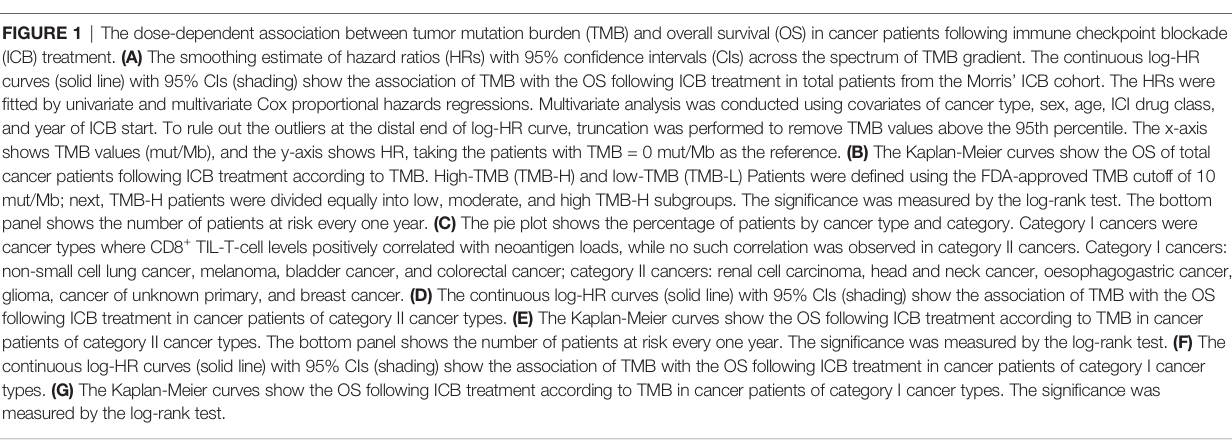
FIGURE 1 | The dose-dependent association between tumor mutation burden (TMB) and overall survival (OS) in cancer patients following immune checkpoint blockade (ICB) treatment. (A) The smoothing estimate of hazard ratios (HRs) with 95% con fi dence intervals (CIs) across the spectrum of TMB gradient. The continuous log-HR curves (solid line) with 95% CIs (shading) show the association of TMB with the OS following ICB treatment in total patients from the Morris ’ ICB cohort. The HRs were fi tted by univariate and multivariate Cox proportional hazards regressions. Multivariate analysis was conducted using covariates of cancer type, sex, age, ICI drug class, and year of ICB start. To rule out the outliers at the distal end of log-HR curve, truncation was performed to remove TMB values above the 95th percentile. The x-axis shows TMB values (mut/Mb), and the y-axis shows HR, taking the patients with TMB = 0 mut/Mb as the reference. (B) The Kaplan-Meier curves show the OS of total cancer patients following ICB treatment according to TMB. High-TMB (TMB-H) and low-TMB (TMB-L) Patients were de fi ned using the FDA-approved TMB cutoff of 10 mut/Mb; next, TMB-H patients were divided equally into low, moderate, and high TMB-H subgroups. The signi fi cance was measured by the log-rank test. The bottom panel shows the number of patients at risk every one year. (C) The pie plot shows the percentage of patients by cancer type and category. Category I cancers were cancer types where CD8 + TIL-T-cell levels positively correlated with neoantigen loads, while no such correlation was observed in category II cancers. Category I cancers: non-small cell lung cancer, melanoma, bladder cancer, and colorectal cancer; category II cancers: renal cell carcinoma, head and neck cancer, oesophagogastric cancer, glioma, cancer of unknown primary, and breast cancer. (D) The continuous log-HR curves (solid line) with 95% CIs (shading) show the association of TMB with the OS following ICB treatment in cancer patients of category II cancer types. (E) The Kaplan-Meier curves show the OS following ICB treatment according to TMB in cancer patients of category II cancer types. The bottom panel shows the number of patients at risk every one year. The signi fi cance was measured by the log-rank test. (F) The continuous log-HR curves (solid line) with 95% CIs (shading) show the association of TMB with the OS following ICB treatment in cancer patients of category I cancer types. (G) The Kaplan-Meier curves show the OS following ICB treatment according to TMB in cancer patients of category I cancer types. The signi fi cance was measured by the